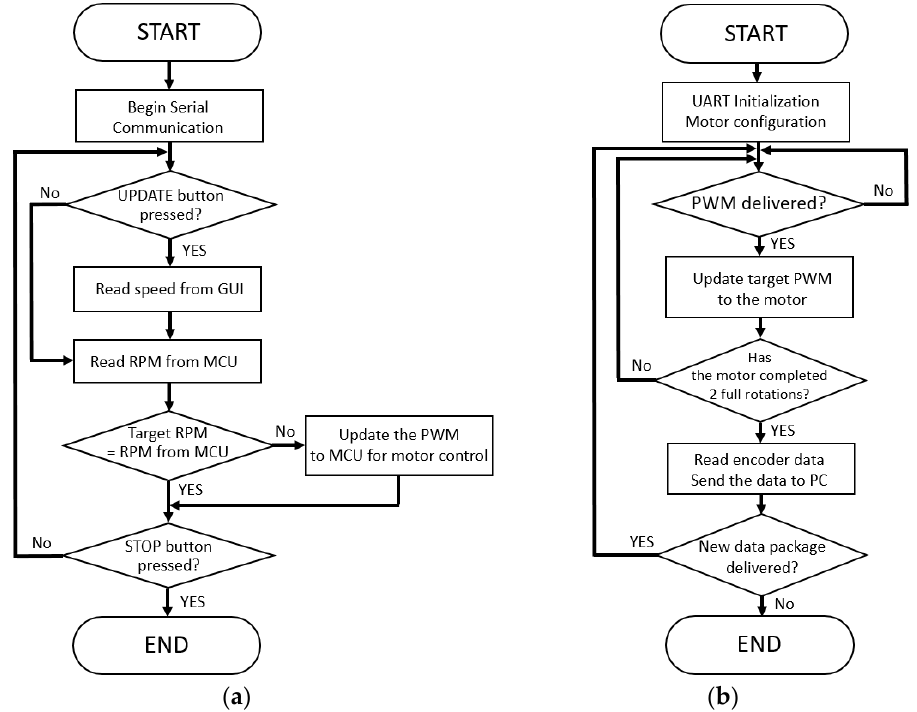
Figure 3. Software flowcharts of the ( a ) LabVIEW interface and ( b ) firmware of the